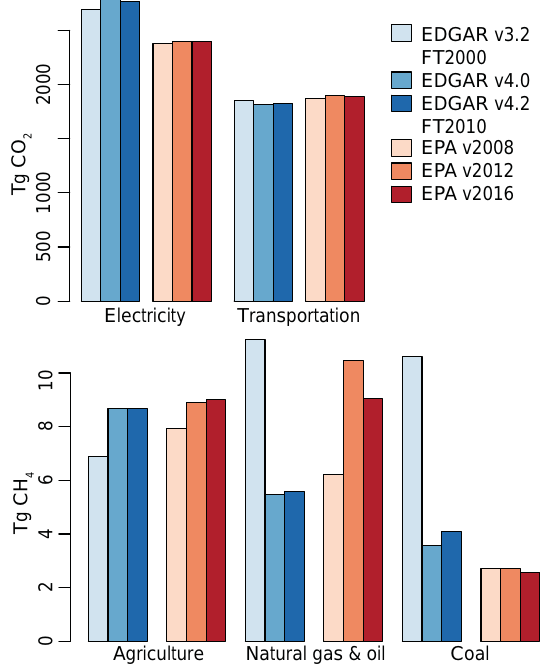
Figure 1. EDGAR and the EPA inventory estimates for different US fossil fuel source sectors (Olivier et al., 2014; US EPA, 2016c), in- cluding several versions of each inventory. CO 2 estimates are con- sistent between the EPA and EDGAR and among inventory ver- sions. CH 4 estimates, however, vary widely, which is an indication of uncertainty in CH 4 emissions. All of the estimates are for 2005 except for EDGAR FT2000, which is for 2000. Note that EDGAR includes CO 2 from heating in its electricity estimate while the EPA does not. As a result, the EDGAR CO 2 estimate is higher than the EPA’s